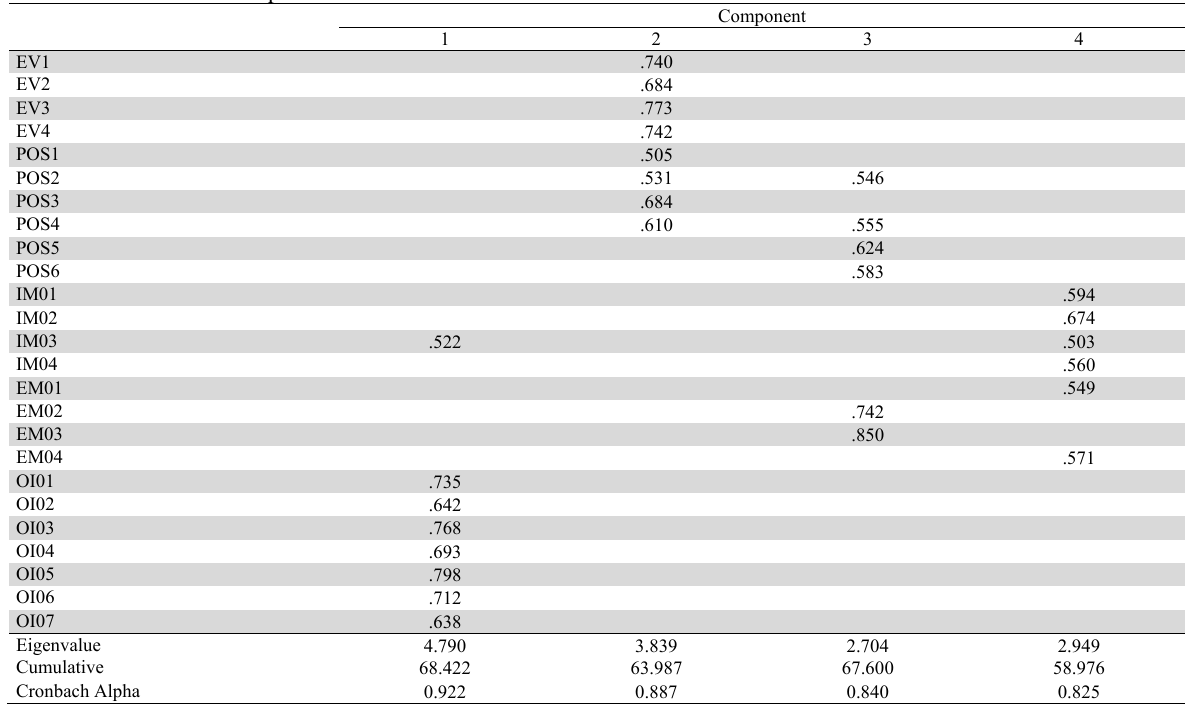
EFA Result – Rotated Component Matrix